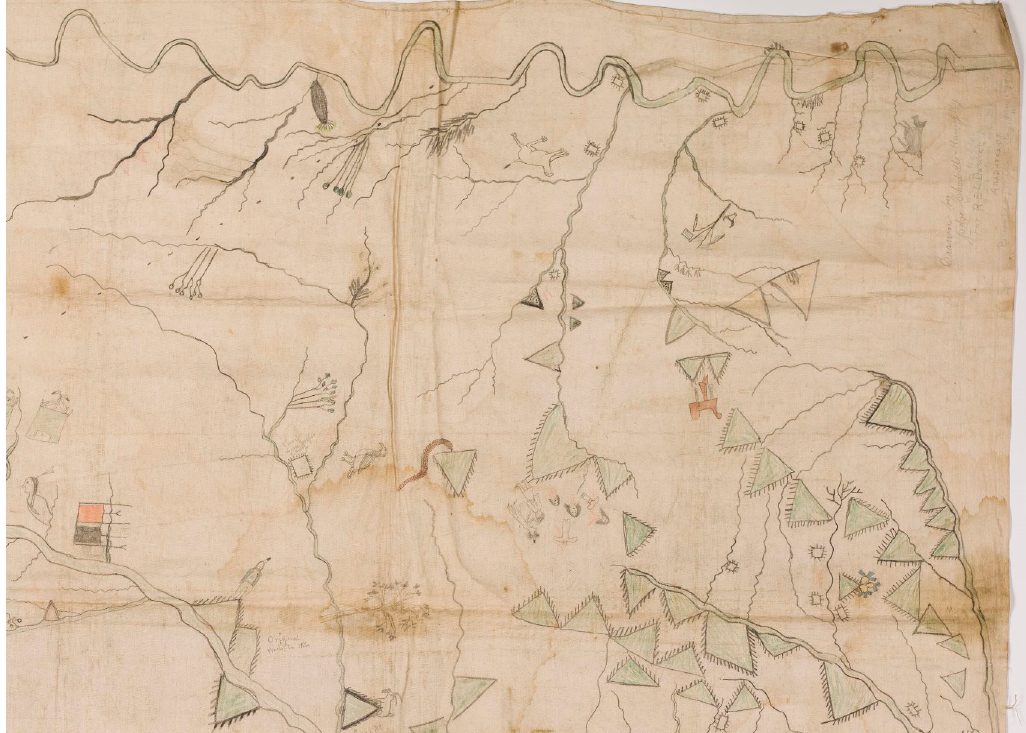
Figure 1. A portion of the Chál ‐ ko ‐ gái map showing rivers, creeks, mountains, and associated pictographs. Source: National Museum of Natural History.